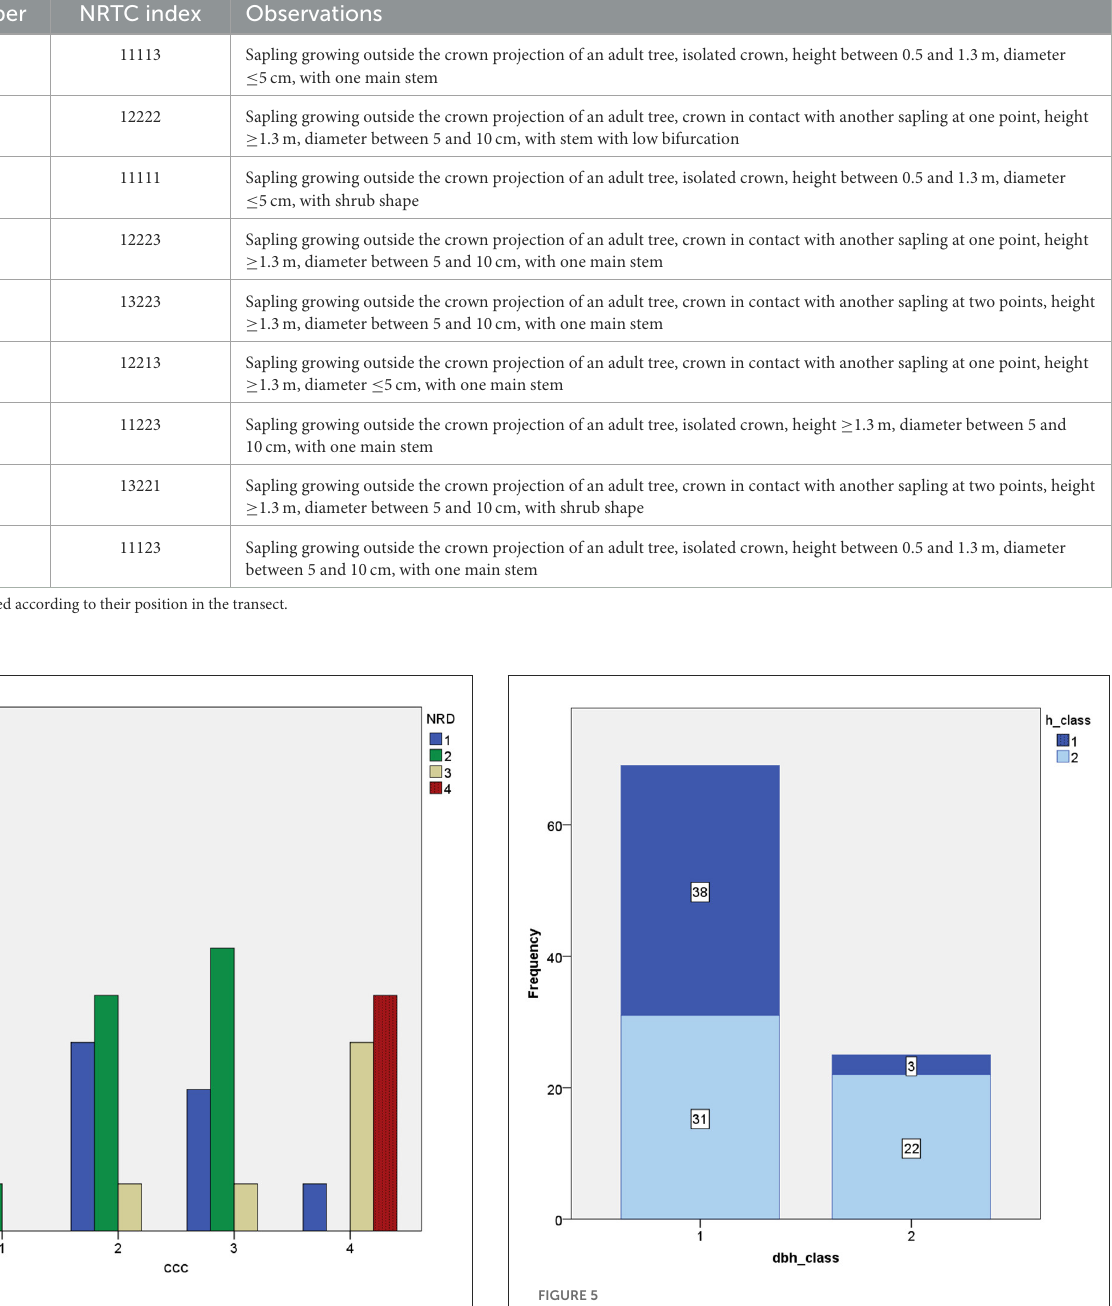
TABLE 2 Examples of NRTC for Quercus ilex with all saplings outside the crown projection of an adult tree. Tree number NRTC index